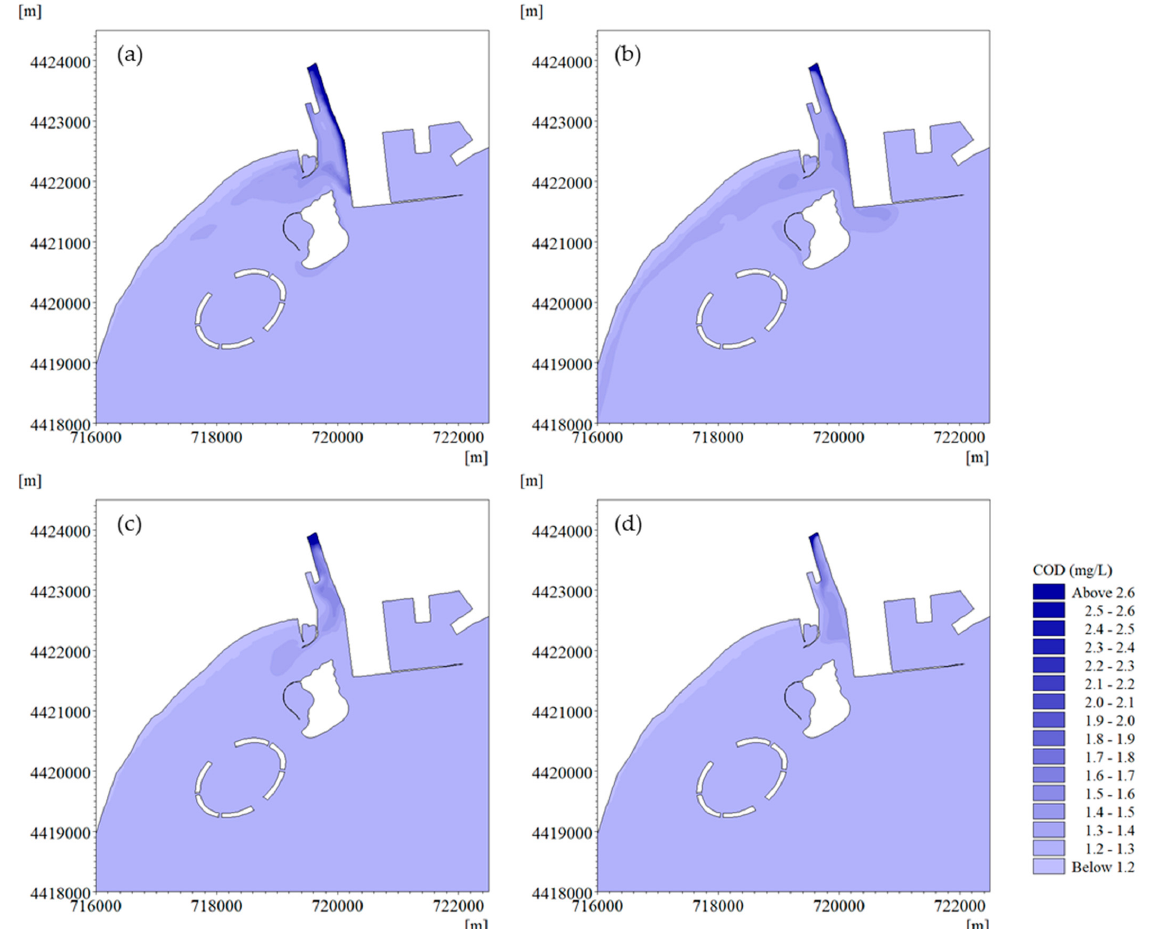
Figure 9. Distributions of COD at ( a ) the peak flood, ( b ) the peak ebb during a typical neap tidal period and ( c ) the peak flood, ( d ) the peak ebb during a typical spring tidal period, under the current construction conditions.